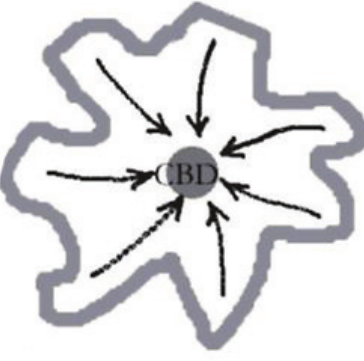
Fig. 2. Mono-centric model of a traditional city Source: Bertaud